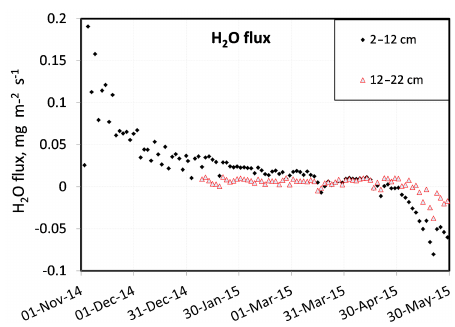
Figure 12. Time series of the water vapour flux at two levels in the snowpack. Positive fluxes are